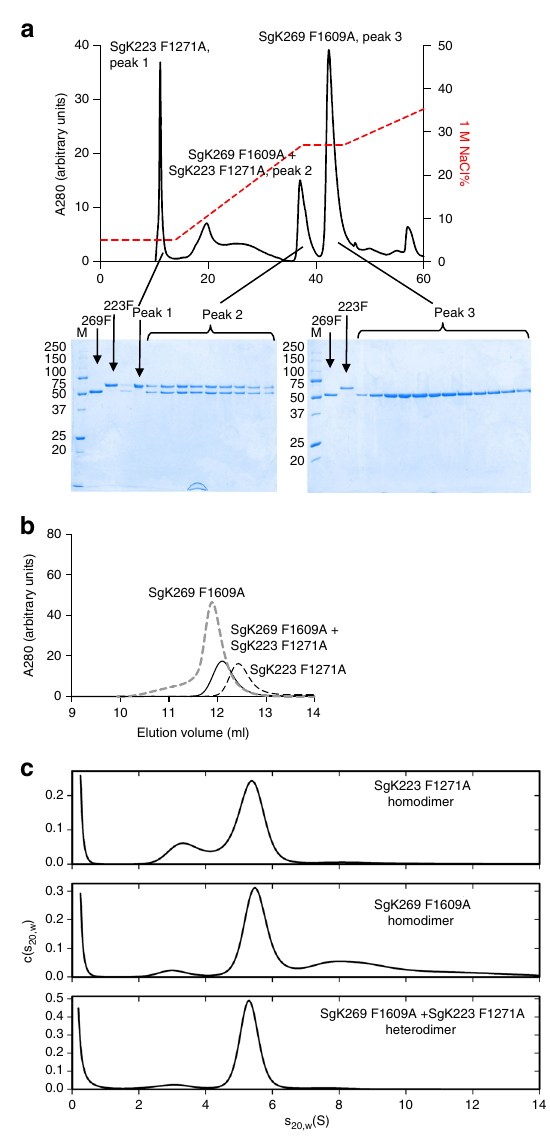
Fig. 7 Heterodimerization of SgK223 and SgK269. a Mono Q (5/50 GL, GE Healthcare) pro fi le of SgK223- α N1-PsK-Cter F1271A/His tag cleaved SgK269- α N1-PsK-Cter F1609A heterodimer complex. SgK223- α N1-PsK- Cter F1271A and His tag cleaved SgK269- α N1-PsK-Cter F1609A were mixed in equal molar ratio at 20 µ M and incubated on ice overnight. The resulting complex was run on Mono Q and eluted by applying 5 – 60% linear gradient of 1 M NaCl. Protein fractions corresponding to the three main peaks of the homodimer of SgK223- α N1-PsK-Cter F1271A (peak 1), heterodimer of SgK223- α N1-PsK-Cter F1271A and SgK269- α N1-PsK-Cter F1609A (peak 2) and homodimer of SgK269- α N1-PsK-Cter F1609A (peak 3) are shown on an SDS-PAGE along with the molecular weight markers. b Size exclusion chromatography analysis (Superdex 200 TM Increase 10/ 300 GL, GE Healthcare) analysis of SgK223- α N1-PsK-Cter F1271A homodimer shown in black dashed line, SgK223- α N1-PsK-Cter F1271A /SgK269- α N1-PsK-Cter F1609A heterodimer shown in black line and SgK269- α N1-PsK-Cter F1609A homodimer shown in grey dashed line. c c ( s α N1-PsK-Cter F1271A and SgK269- α N1- 20,w ) distributions for SgK223- PsK-Cter F1609A homodimers in comparison to SgK223- α N1-PsK-Cter F1271A and SgK269- α N1-PsK-Cter F1609A heterodimer, each analysed at a concentration of 1.2 μ M. See also Supplementary Fig.